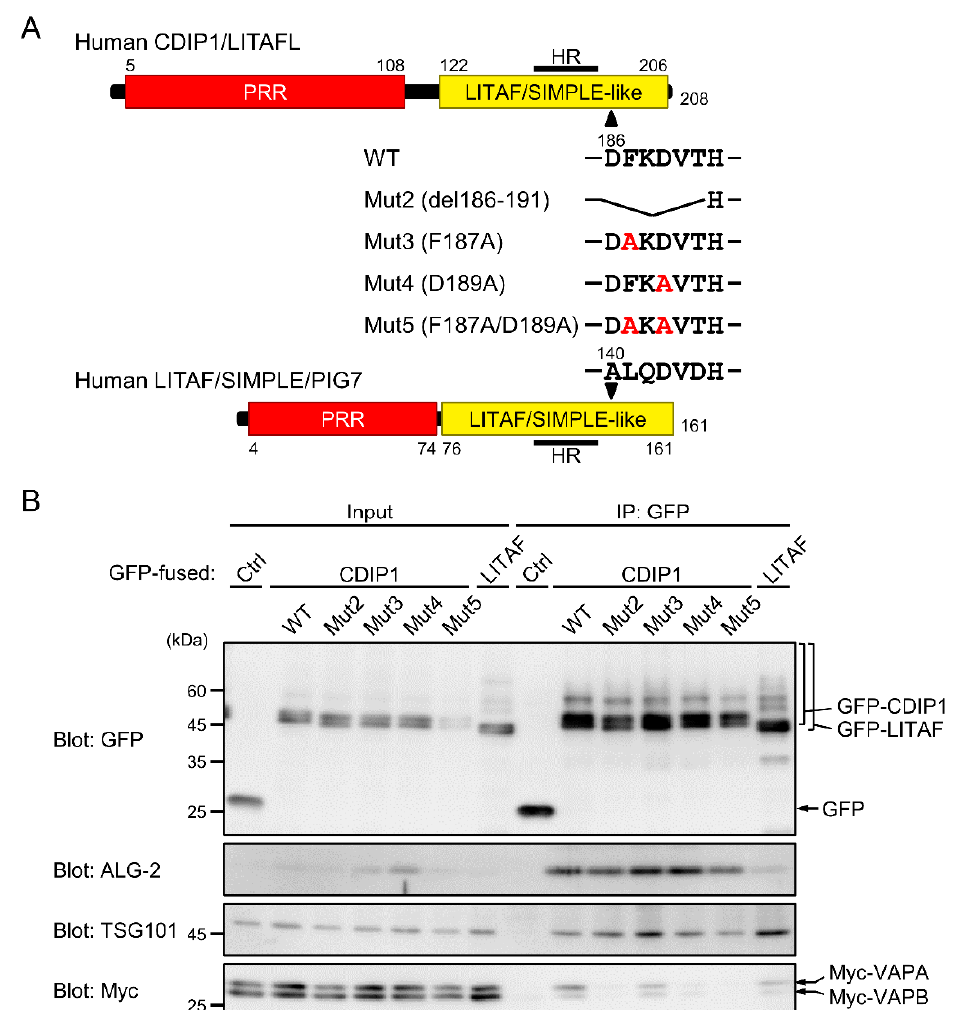
Figure 8. Effects of mutations in the FFAT-like motif on the interaction of CDIP1 with VAPA, VAPB, ALG-2 and TSG101. ( A ) Schematic diagram of mutations at the FFAT-like motif in the C-terminal LITAF/SIMPLE-like domain of CDIP1. HR, hydrophobic region. ( B ) HEK293 cells were transiently transfected with expression plasmids for Myc-VAPA and Myc-VAPB in combination with expression plasmids for GFP (Ctrl), GFP-CDIP1 (WT), GFP-CDIP1 mutants (Mut2–5) or GFP-LITAF/SIMPLE (LITAF). Cleared cell lysates (Input) and IP products (IP) obtained with the GFP nanobody in the presence of 10 µ M CaCl 2 were subjected to SDS-PAGE followed by immunoblotting with antibodies against GFP, ALG-2, TSG101 and Myc tag. The relative amounts of cleared cell lysate proteins (Input) used for analysis of IP products (IP) were 10% (upper panel) and 1.3% (other